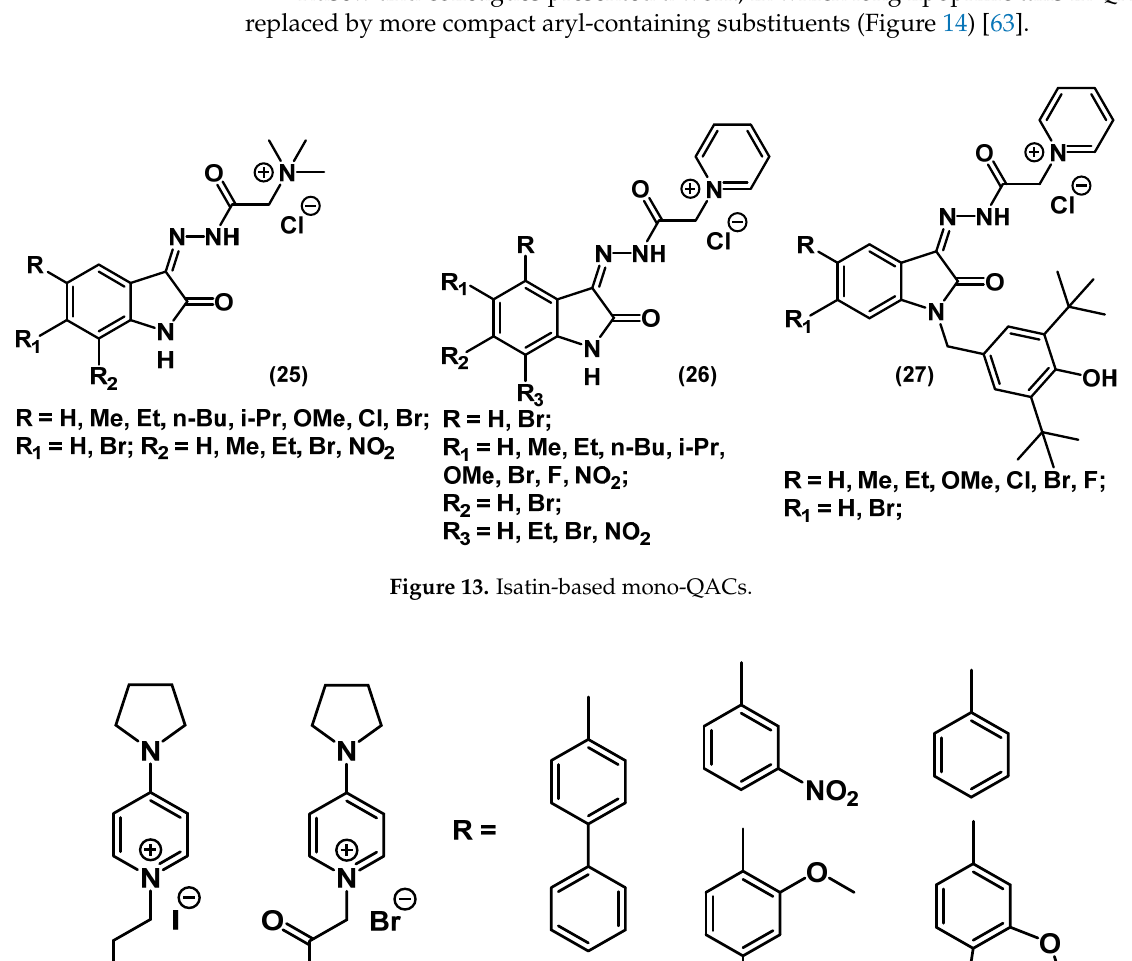
Figure 13. Isatin-based mono-QACs.